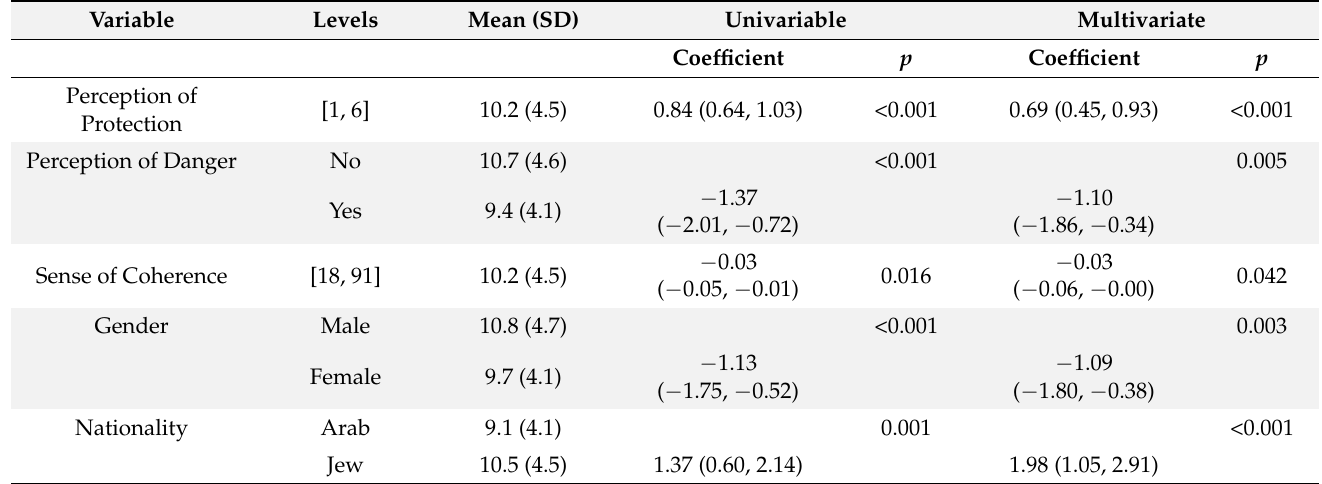
Table 2. Multivariate analysis of variables associated with social distancing